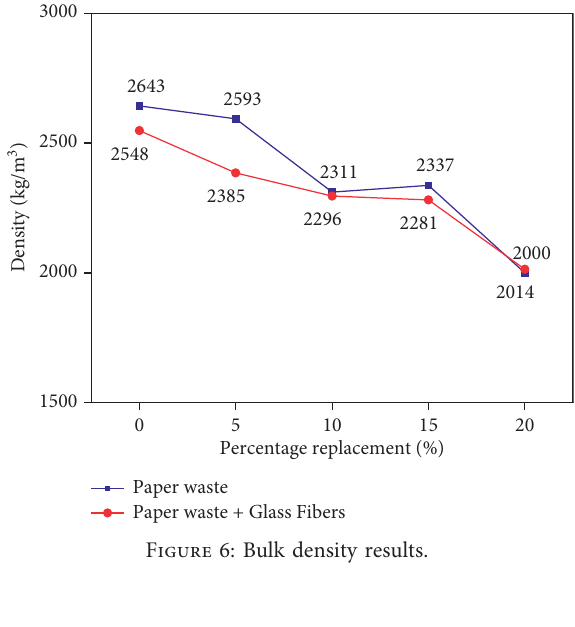
Figure 6: Bulk density results.